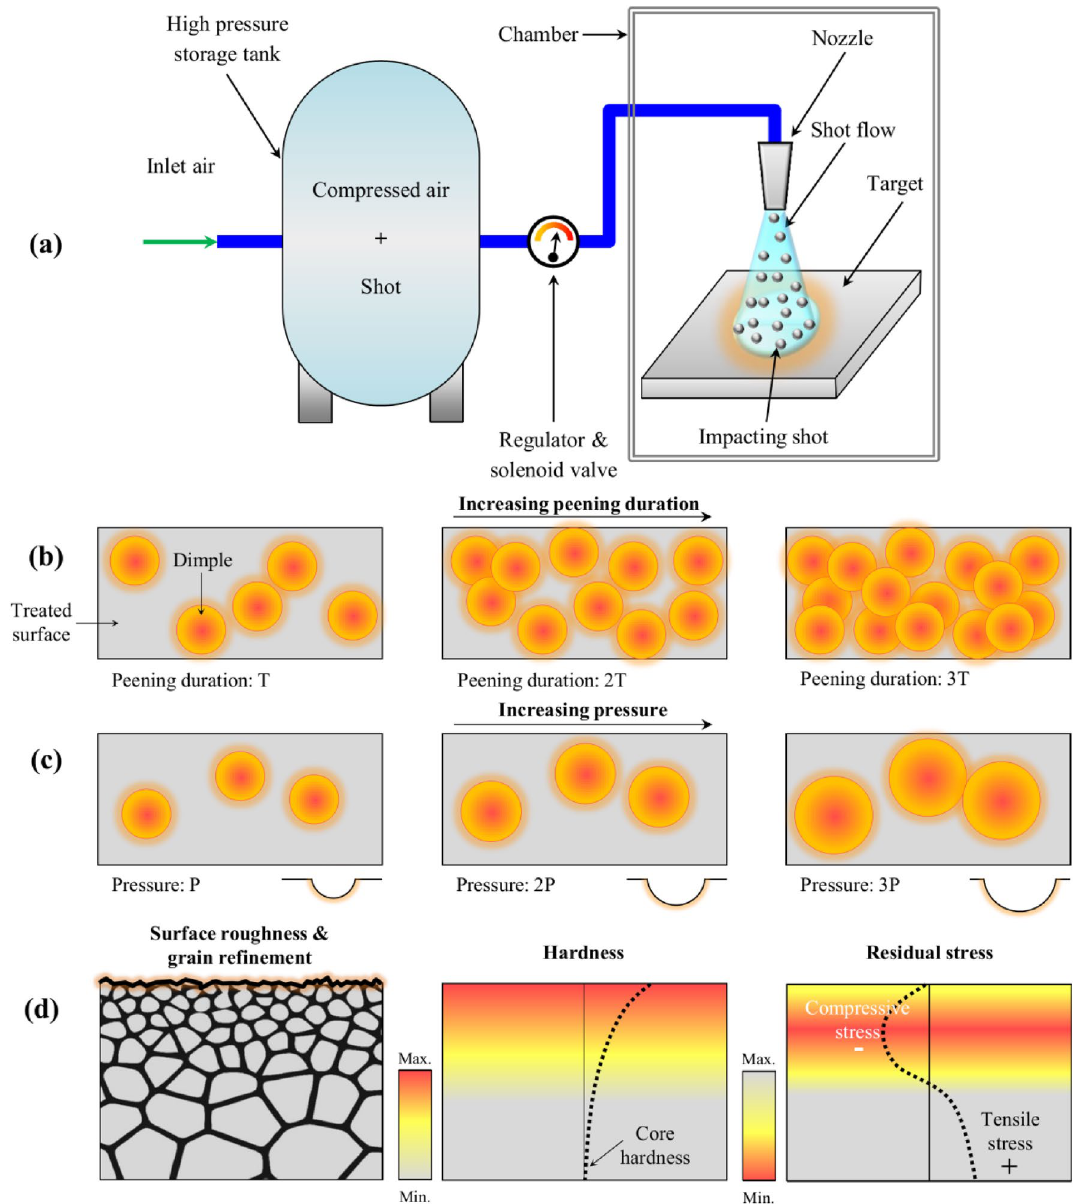
Figure 1. Schematic illustration of ( a ) air blast SP equipment; effects of SP treatments in terms of increasing the ( b ) peening duartion and ( c ) projection pressure on the target surface ( d ) common effects of SP treatment on increasing the surface roughness and inducing surface layer grain refinment, hardening and inducing compressive residual stresses, from left to